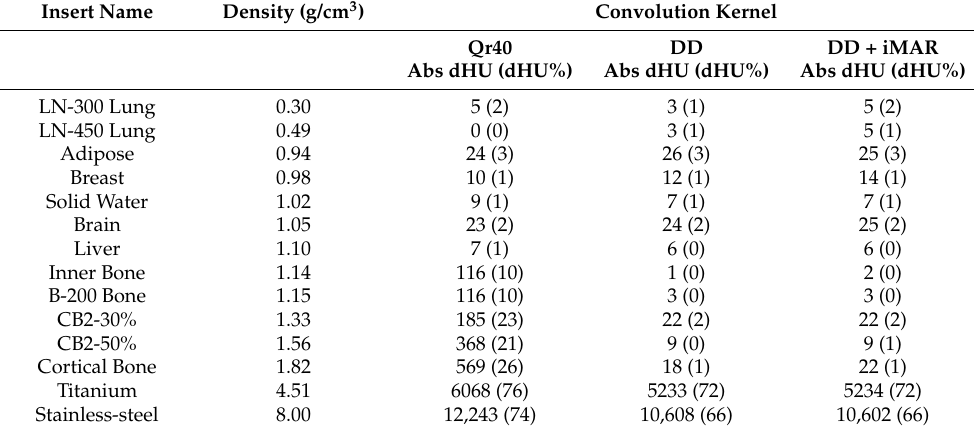
Figure 7. The absolute difference in HU or HU DD between the average calibration curve corresponding to the acquisition at 80 kVp and the average calibration curve corresponding to the acquisition at 140 kVp, for each set of curves related to each reconstruction algorithm. The curve related to the DD reconstruction (DD) matched the curve related to the combined reconstruction DD + iMAR. Table 4. The absolute and percentage differences (percentage differences between brackets) in the HU or HU DD between the average calibration curve corresponding to the acquisition at 80 kVp and the average calibration curve corresponding to the acquisition at 140 kVp, for each set of curves related to each reconstruction algorithm.